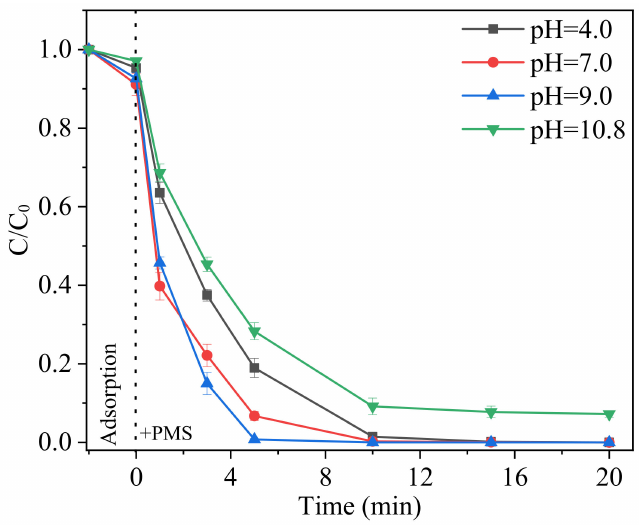
Figure 3. Effect of initial pH on BPA degradation; [BPA] 0 = 10 mg/L, [PMS] 0 = 0.10 mM and [Mn 2 O 3 ] 0 = 0.2